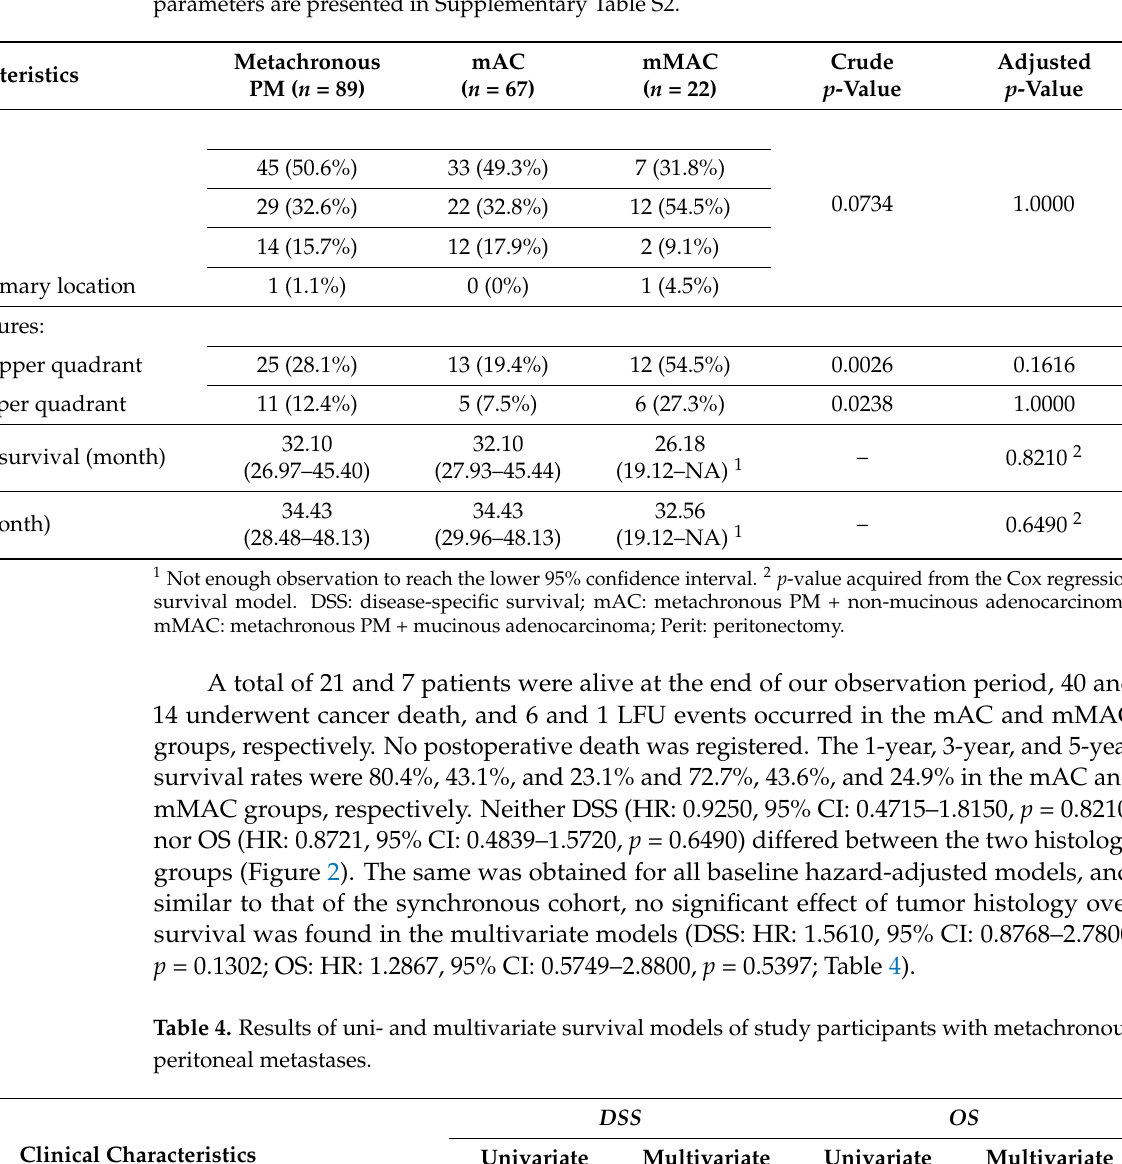
Table 3. Pre-, peri-, and postoperative demographic and clinical characteristics of study participants with metachronous peritoneal metastases (PM). Unit of frequency and survival data are the number of observations (percentage) and median survival time (95% confidence interval), respectively. Further parameters are presented in Supplementary Table S2.